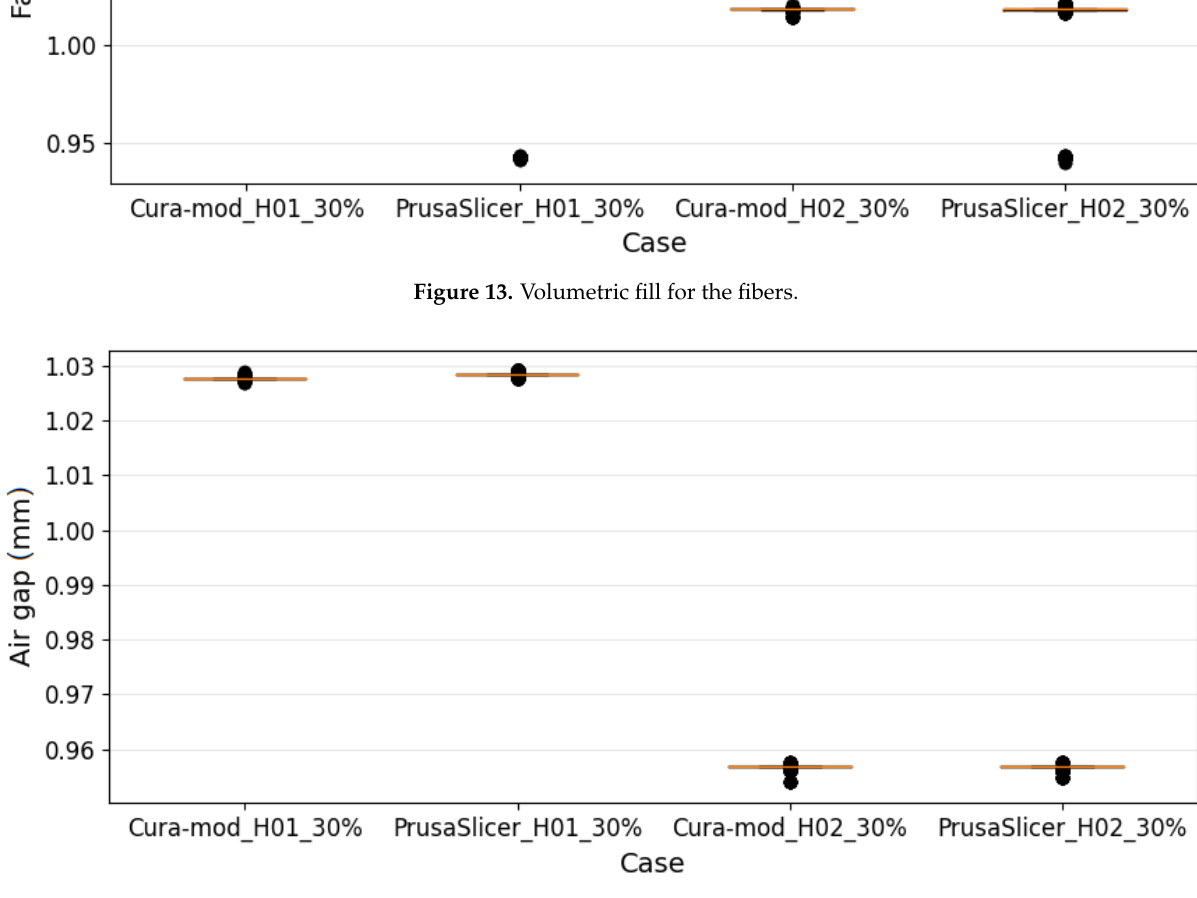
Figure 14. The in-plane distances between the